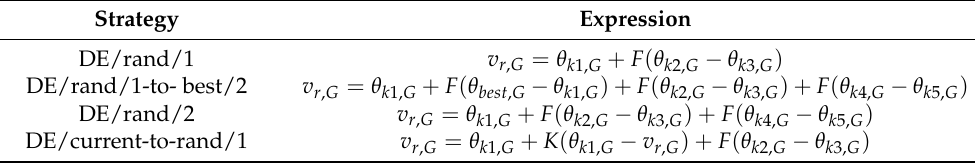
Table 2. Mutation